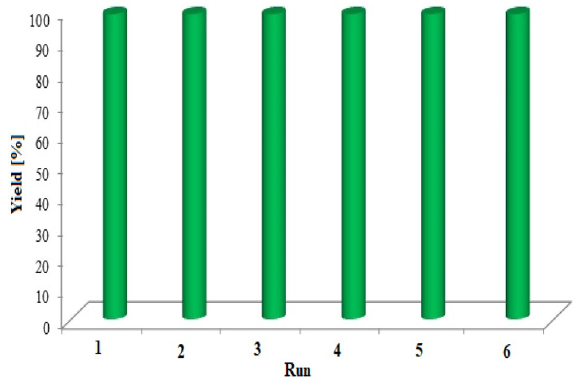
Figure 8. Recycling experiments of the Fe 3 O 4 /GO/[FeMo 6 ].